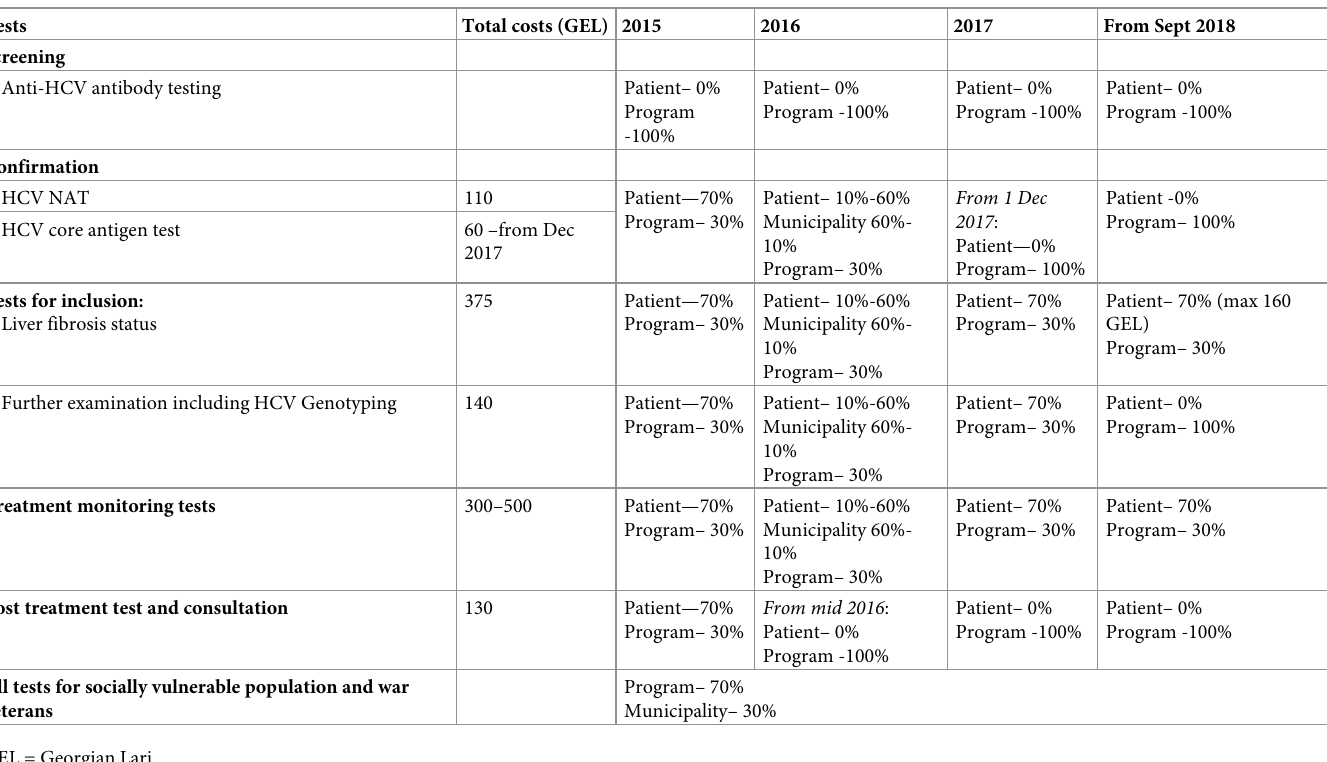
Table 1. HCV diagnostics, treatment monitoring and post-treatment tests cost